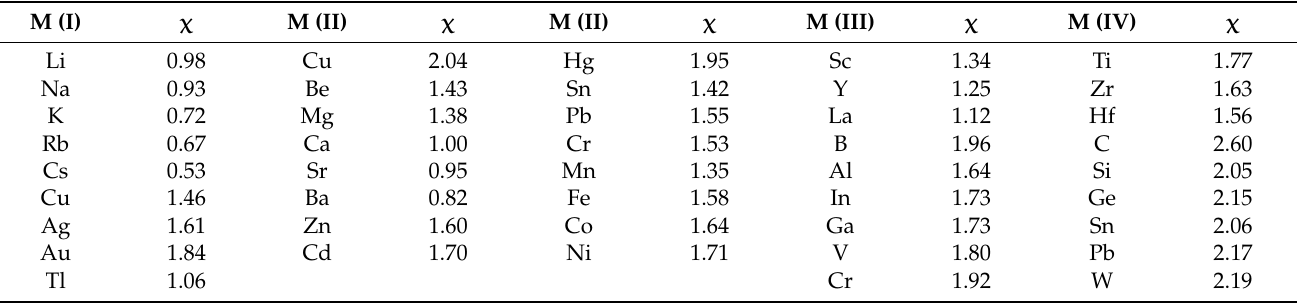
Table 2. Thermochemical electronegativity of metals in molecular